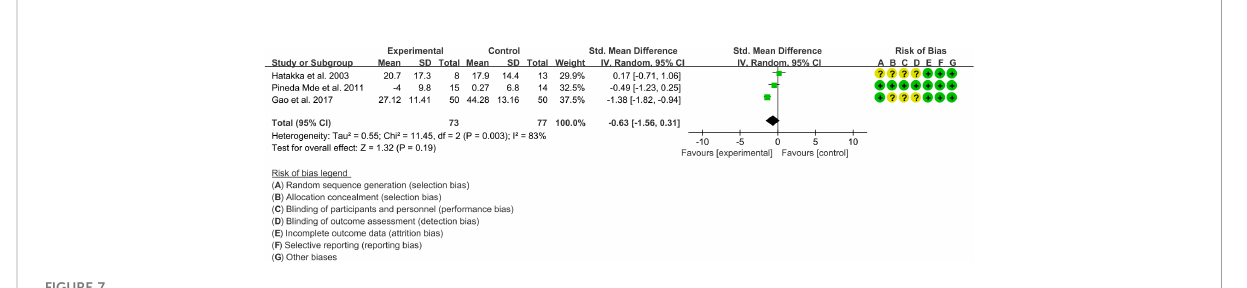
FIGURE 7 The results of ESR (CI, con fi dence interval; SD, standard